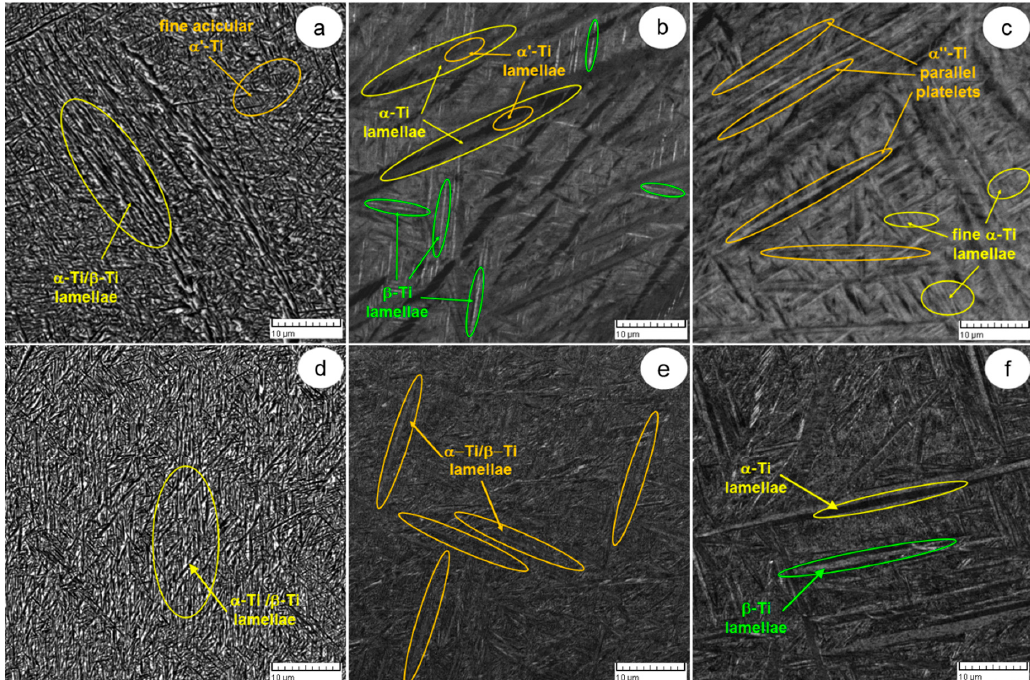
Figure 6. SEM-BSE images of ( a ) solution treated at 800 °C (ST1) state; ( b ) solution treated at 900 °C (ST2) state; ( c ) solution treated at 1000 °C (ST3) state; ( d ) solution treated at 800 °C and aged at 600 °C (ST1 + A) state; ( e ) solution treated at 900 °C and aged at 600 °C (ST2 + A) state; ( f ) solution treated at 1000 °C and aged at 600 °C (ST3 + A) state.